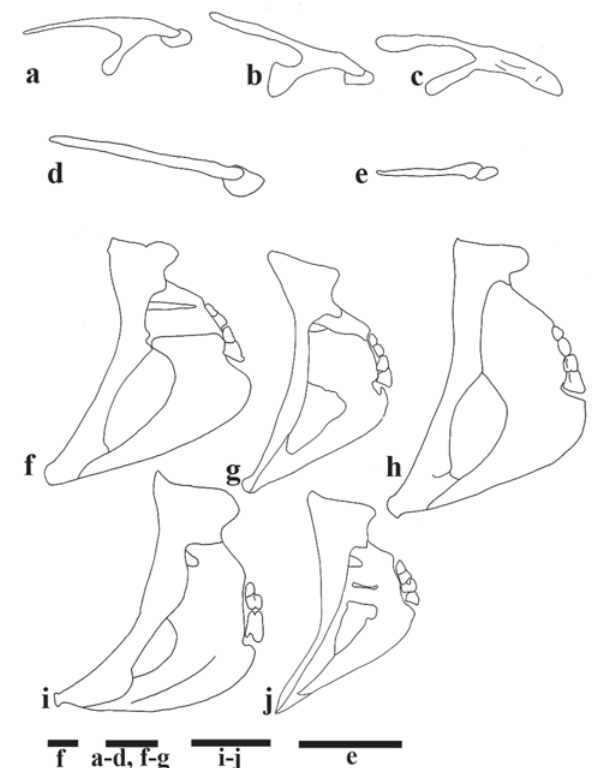
Fig. 6. Lateral view of post-temporal and supracleithrum in: a ) Brachyrhaphis terrabensis , AMNH 2503; b ) Alfaro cultratus , TU 24927; c ) Anableps dowi , TU 39076; d ) Pseudoxiphophorus bimaculatus , TU 183396; e ) Heterandria formosa , TU 24002; pectoral fin girdle in: f ) Pseudoxiphophorus bimaculatus , TU 183396; g ) Brachyrhaphis terrabensis , AMNH 2503; h ) Brachyrhaphis episcopi , SU 50303; i ) Phalloceros caudimaculatus , MCP 40527; j ) Heterandria formosa , TU 24002 . Scale bars = 1